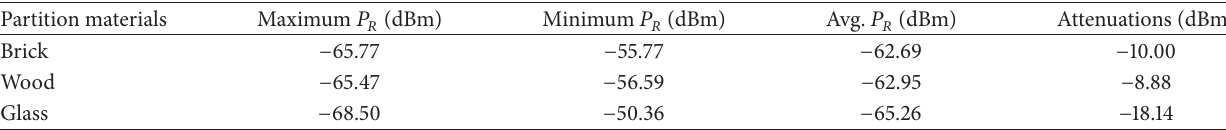
Table 3: Obtained minimum, maximum, average, and deviations of received power when an AP moves along a specific direction within the given